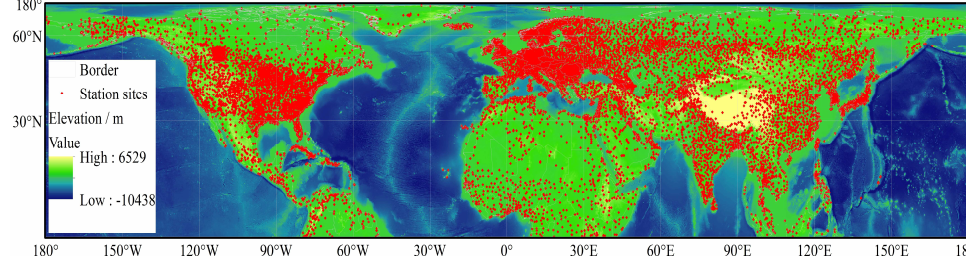
Figure 1. Distribution of meteorological stations overlaid on ETOPO1 topography information in the Northern Hemisphere.